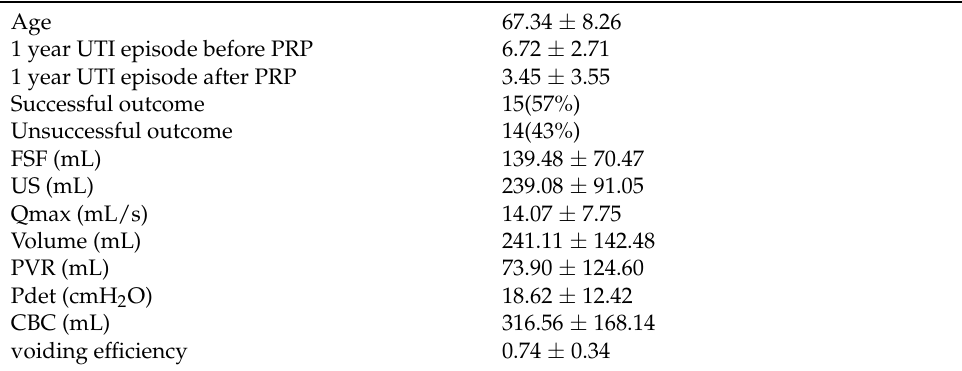
Table 1. The baseline clinical and urodynamic characteristics in the patients with rUTIs ( n = 29).